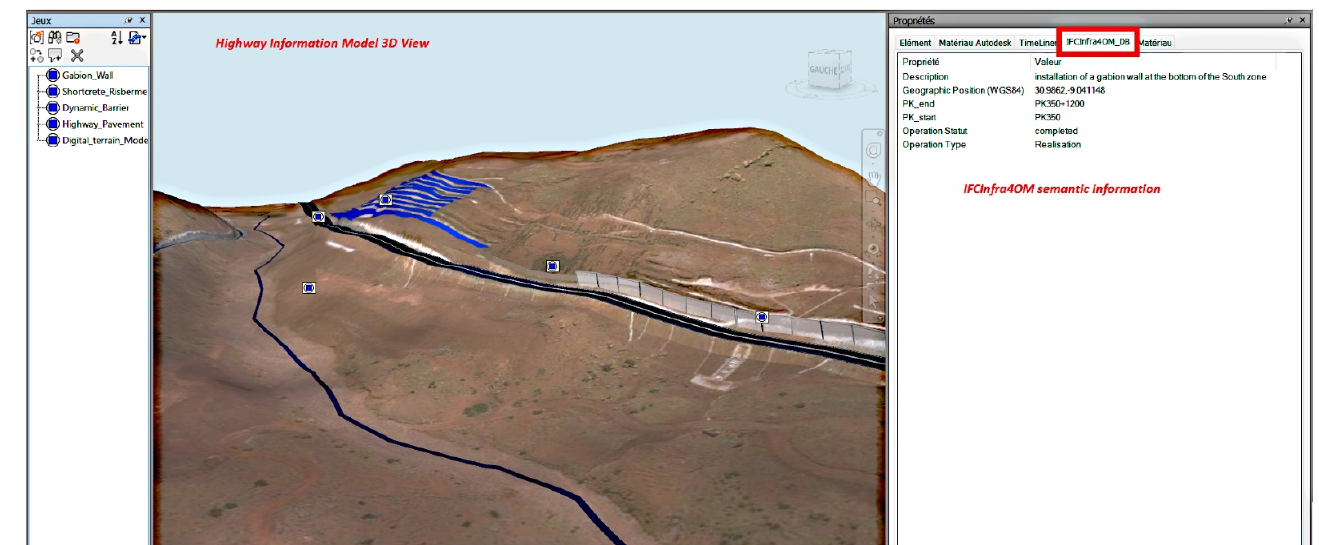
ISPRS Int. J. Geo-Inf. 2021 , 10 , x FOR PEER REVIEW Figure 6. ClosedBIM approach application to the O&M of the A7 Moroccan highway segment [25].